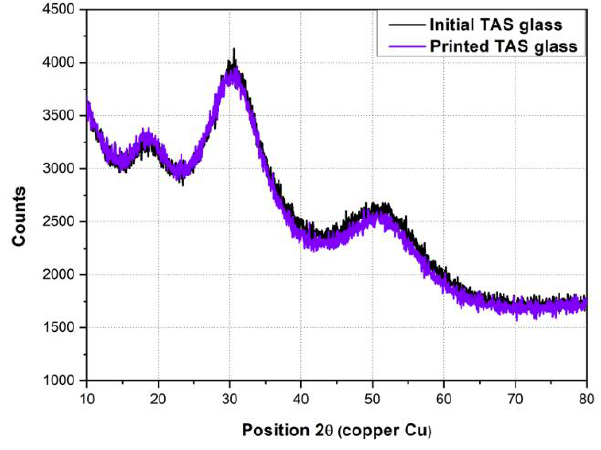
Figure 4. XRD diagrams of initial TAS glass (black curve) and printed TAS glass (purple curve).